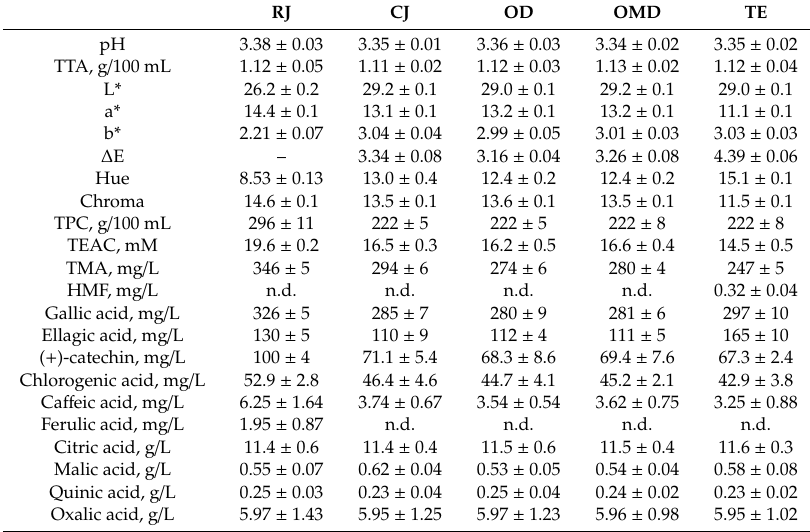
Table 3. Variations in chemical composition and main characteristics of pomegranate juice following clarification and di ff erent concentration processes